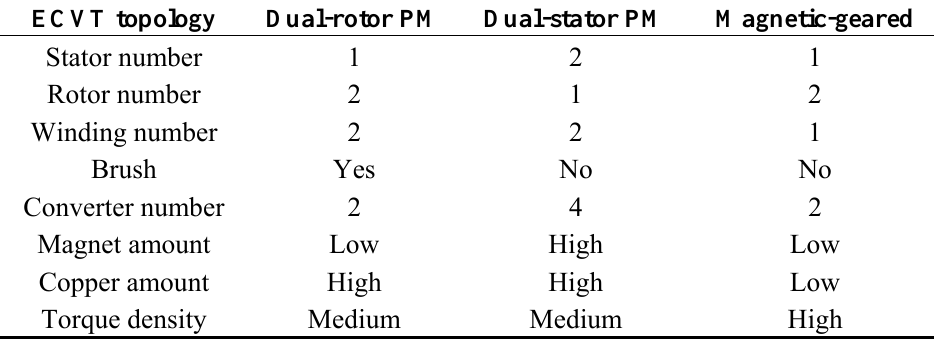
Table 4. Comparison of different ECVT